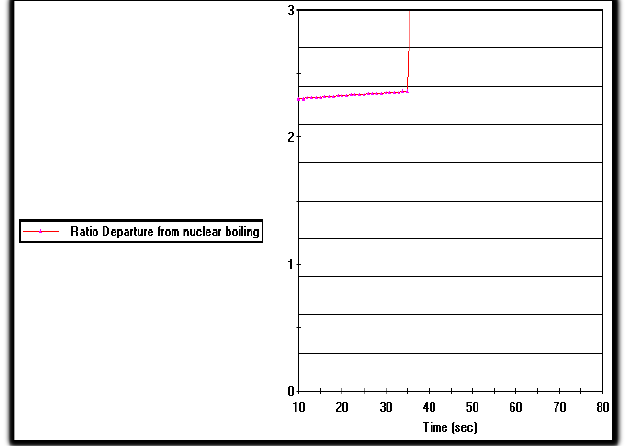
Fig. 22. Transient departure from nuclear boiling under inadvertent opening of pressurizer safety valves